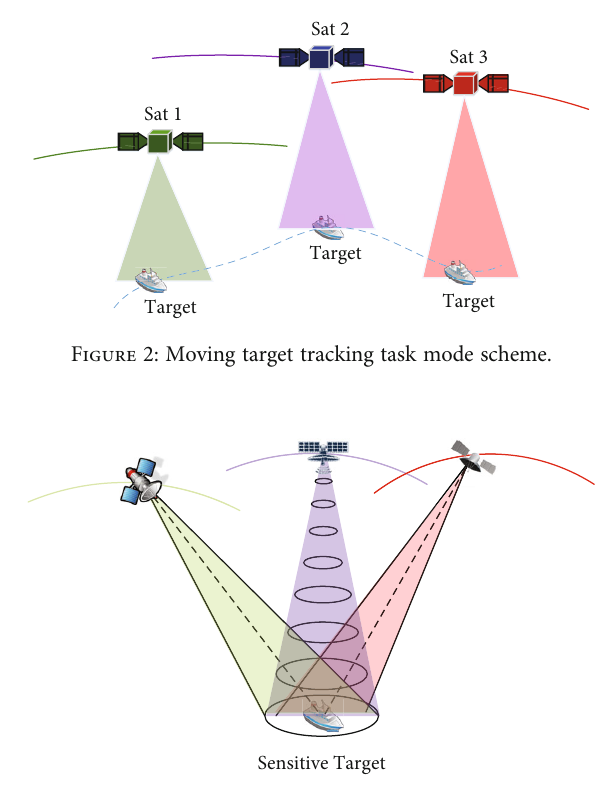
Figure 3: Sensitive target feature con fi rmation task mode